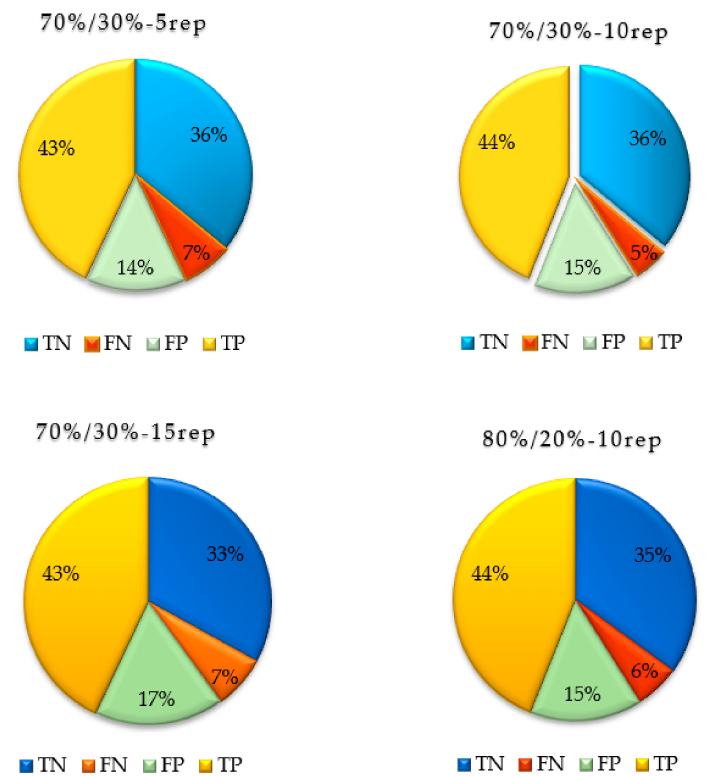
Figure 7. Contingency matrix applied for assessing the MARS model for all